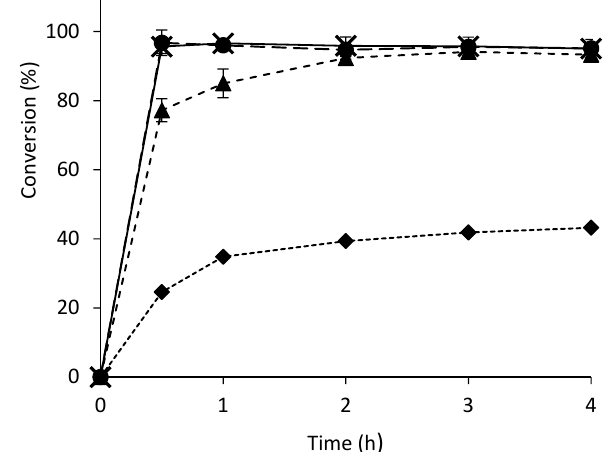
Figure 2. E ff ect of immobilization method and drying on the synthesis of ( R )-mandelonitrile. Continuous line and crosses is the reaction with wet At HNL-EziG Opal (adsorption), final ee = 96.2%; dashed line and dots is the reaction with dried At HNL-EziG Opal (adsorption) final ee = 93.8%; dashed line and triangles is the reaction with wet At HNL-EziG Opal (incubation in orbital shaker), final ee = 92.3% and dotted line and diamonds is the reaction with dried At HNL-EziG Opal (incubation in orbital shaker), final ee = 63.3%. Conditions: Ratio benzaldehyde:HCN in citrate / phosphate bu ff ered MTBE, pH 5, 1:4, benzaldehyde (100 µ L, 1 mmol), 2 mL HCN solution in citrate / phosphate bu ff ered MTBE (1.5–2 M) pH 5, 27.5 µ L (0.1 mmol) 1,3,5-triisopropylbenzene as I.S. and a teabag filled